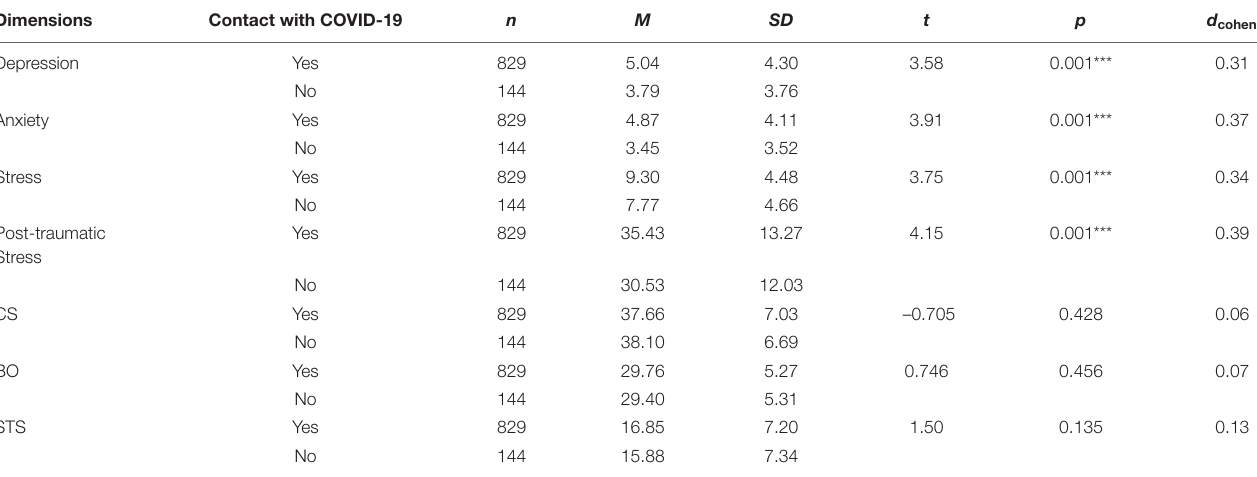
TABLE 6 | Results of univariate analysis of variance for different symptoms according to whether the participants had been in contact with COVID-19.